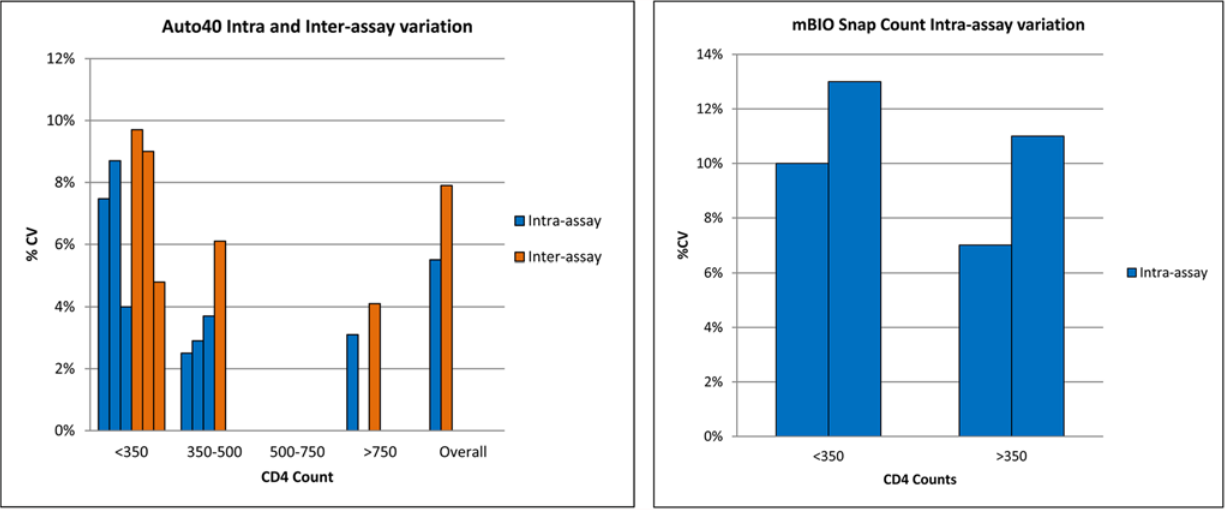
Fig 5. Intra- and inter-assay variation (% CV) for the Apogee Auto 40 and for the MBio SnapCount at thresholds < 350 cells/mL and > 350